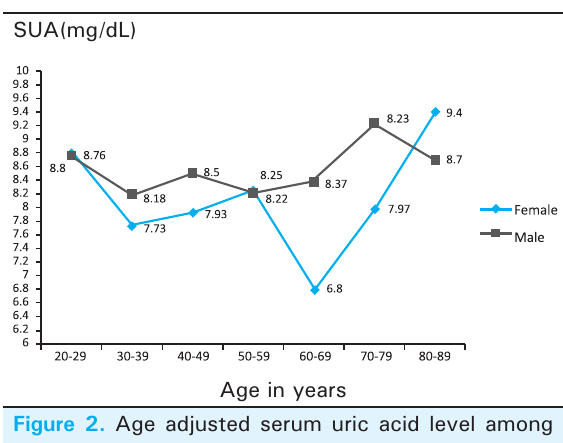
Acute gouty arthritis